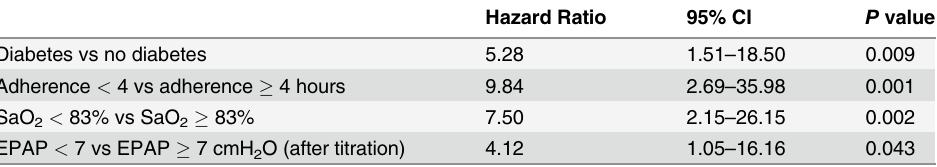
Table 4. Independent predictors of mortality on Multivariate Analysis for OHS